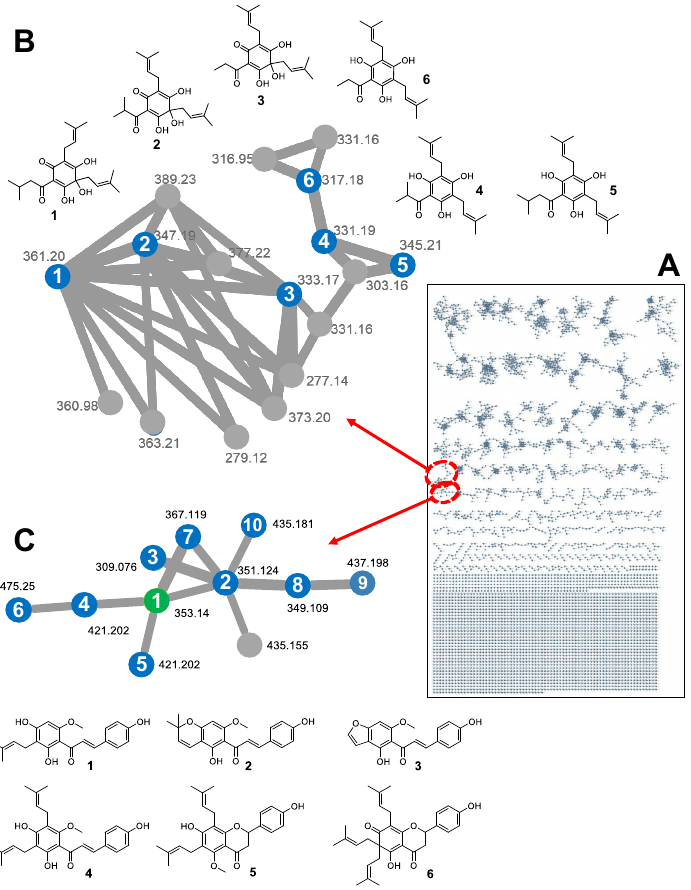
Figure 7. Molecular network generated from the negative ion MS/MS data. ( A ) The network consists of 5122 nodes and 393 clusters, defined as a group of nodes consisting of at least two connected nodes. ( B ) The enlarged humulone cluster shows (ad)humulone 1 , cohumulone 2 , posthumulone 3 , 4-deoxycohumulone 4 , 4-deoxy(ad)humulone 5 , and 4-deoxyposthumulone 6 . ( C ) The enlarged prenylflavonoid cluster shows xanthohumol ( 1 , green node) and structurally related prenylated fla- vonoids (blue nodes): xanthohumol C ( 2 , [40]), xanthohumol O ( 3 , [44]), 5′-prenylxanthohumol or 5′-prenylisoxanthohumol ( 4 or 5 , [39]), isoxantholupon ( 6 , [44]), and structurally related but un- known compounds 7 – 10 . All structures are consistent with the accurate masses measured by HR- MS. 3.3.3. Validation Study To validate the model’s result, finding xanthohumol as the most important predictor of bioactivity in the iNOS inhibition cell assay, we assayed the dose-response curve for xanthohumol and some of the late chromatographic fractions (30–38; see Figure 8). Pure xanthohumol-treated cells ranged from a nitrite concentration of 652.1 nmol/mL (0.23 µM XN) to 23.7 nmol/mL (60 µM XN) (Figure 8). The xanthohumol concentrations of the hops fractions 30–38 were determined by quantitative liquid chromatographic and mass spectrometric detection. Concentrations were determined by known preparations of ten-point external calibration curves. The following concentrations of xanthohumol were measured in triplicate for 20 µg/mL hops fractions 30–38: fraction 30, 0.0458 µg/mL (sd ± 0.00113 µg/mL); fraction 31, 0.602 µg/mL (sd ± 0.00323 µg/mL); fraction 32, 1.31 µg/mL (sd ± 0.00639 µg/mL); fraction 332 µg/mL (sd ± 0.00574 µg/mL); fraction 34, 3.46 µg/mL (sd ± 0.0815 µg/mL); fraction 35, 3.29 µg/mL (sd ± 0.0389 µg/mL); fraction 36, 2.91 µg/mL (sd ±